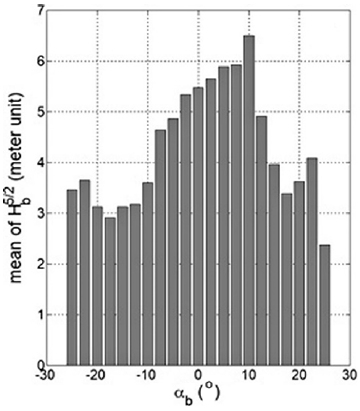
/ 2 per 2.5 ◦ interval of oblique b